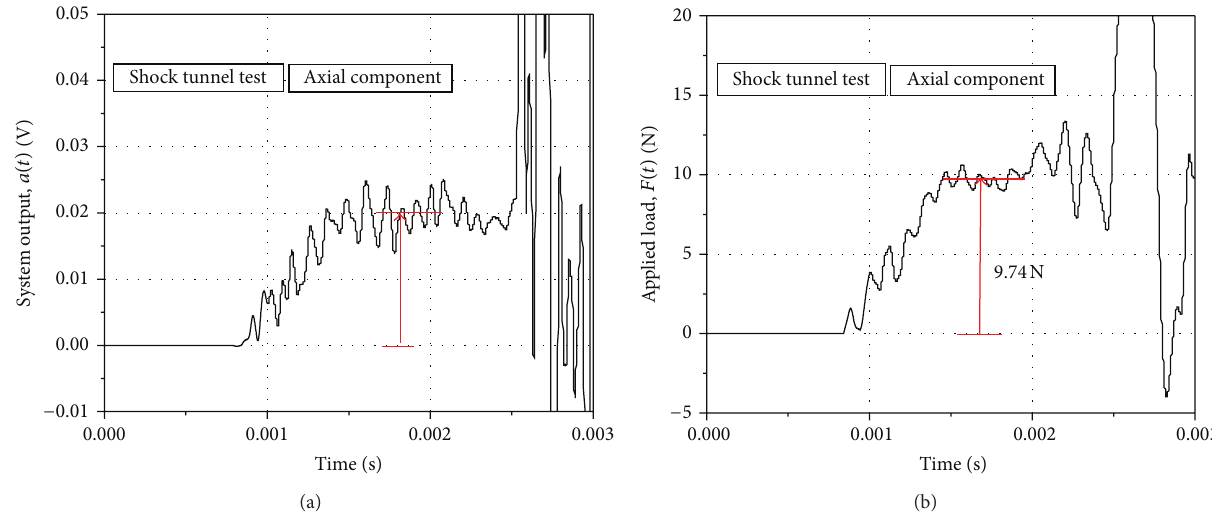
Figure 5: (a) System output and (b) deconvoluted applied load for axial component for aerodynamic test in shock tunnel. Model AOA = 10 ∘ .